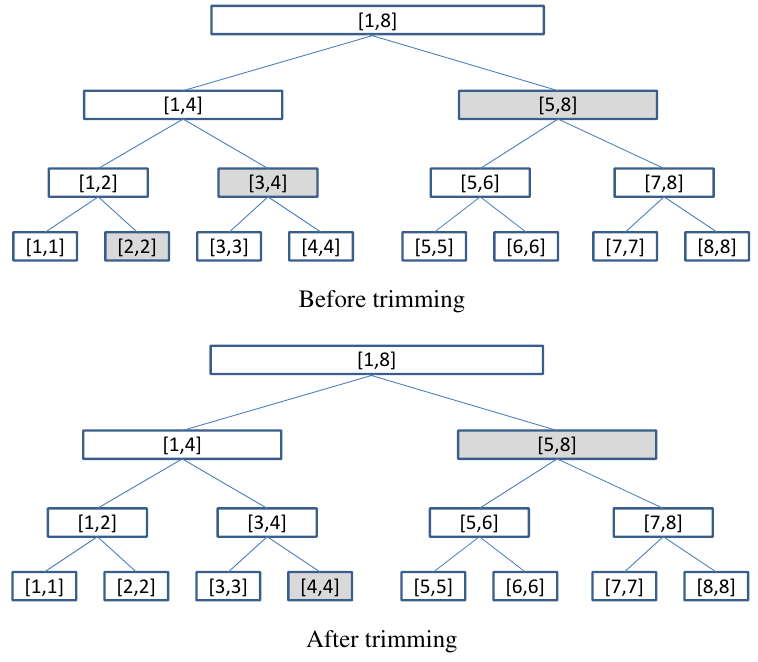
, C , C (cid:105) , 3 [2 , 2] ,λ,κ [3 , 4] ,λ,κ [5 , 8] ,λ,κ